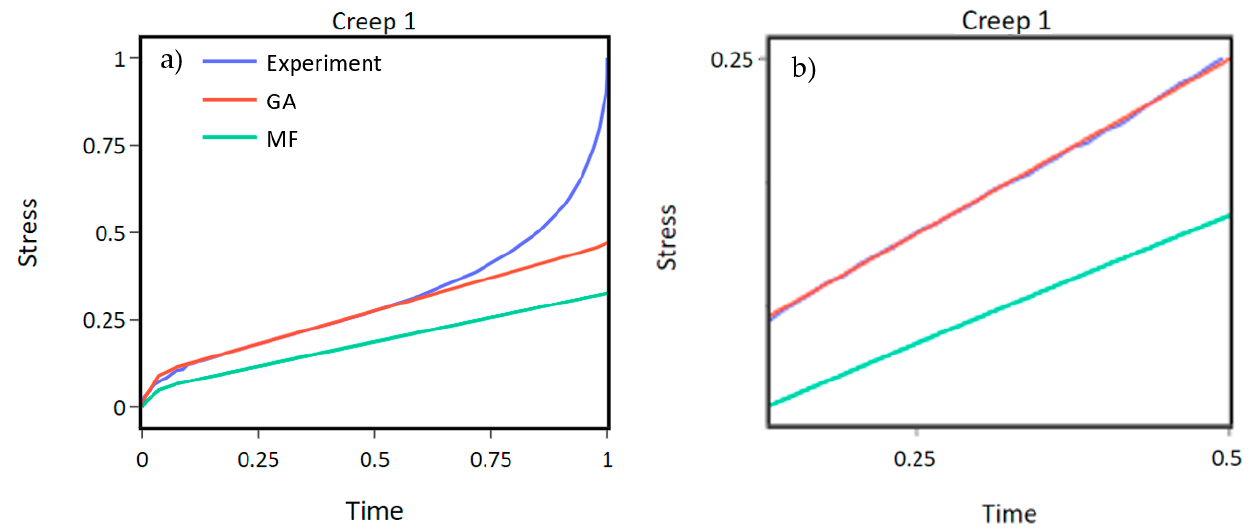
Figure 8. GA and MF methods compared to the experimental creep 1 curve. ( a ) shows the whole creep curve. ( b ) is focused on the linear part of the curve. The GA finds a better fit than the MF method.